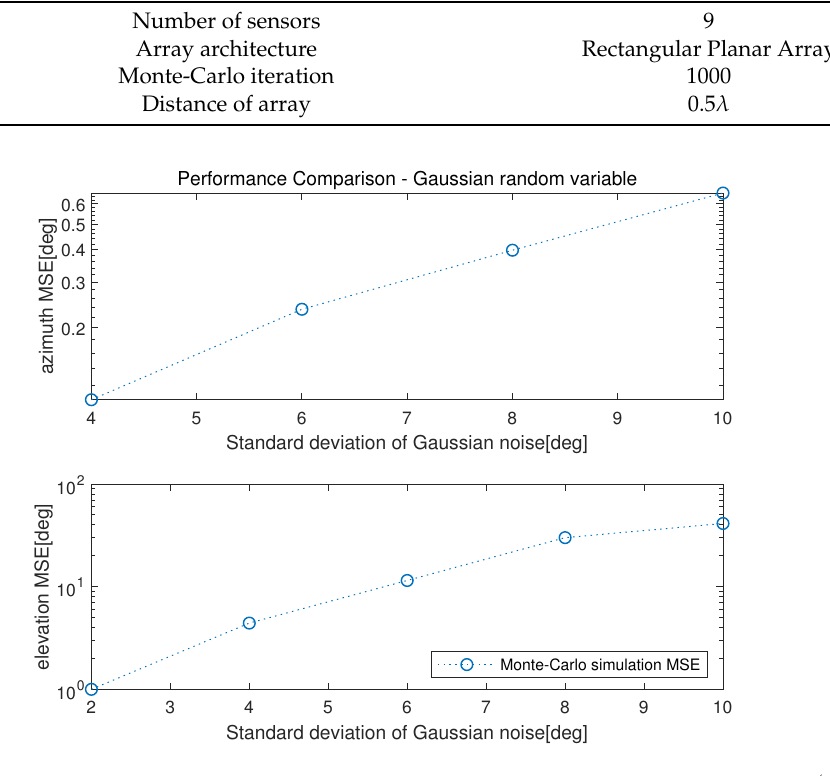
Figure 8. Performance for Gaussian − distributed phase measurement error with θ ( 0 ) = 120 ◦ and ψ ( 0 ) = 15 ◦ . This figure shows the MSEs of azimuth and elevation with respect to phase error at a signal with low incident elevation by monte-carlo simulation(rectangular plannar